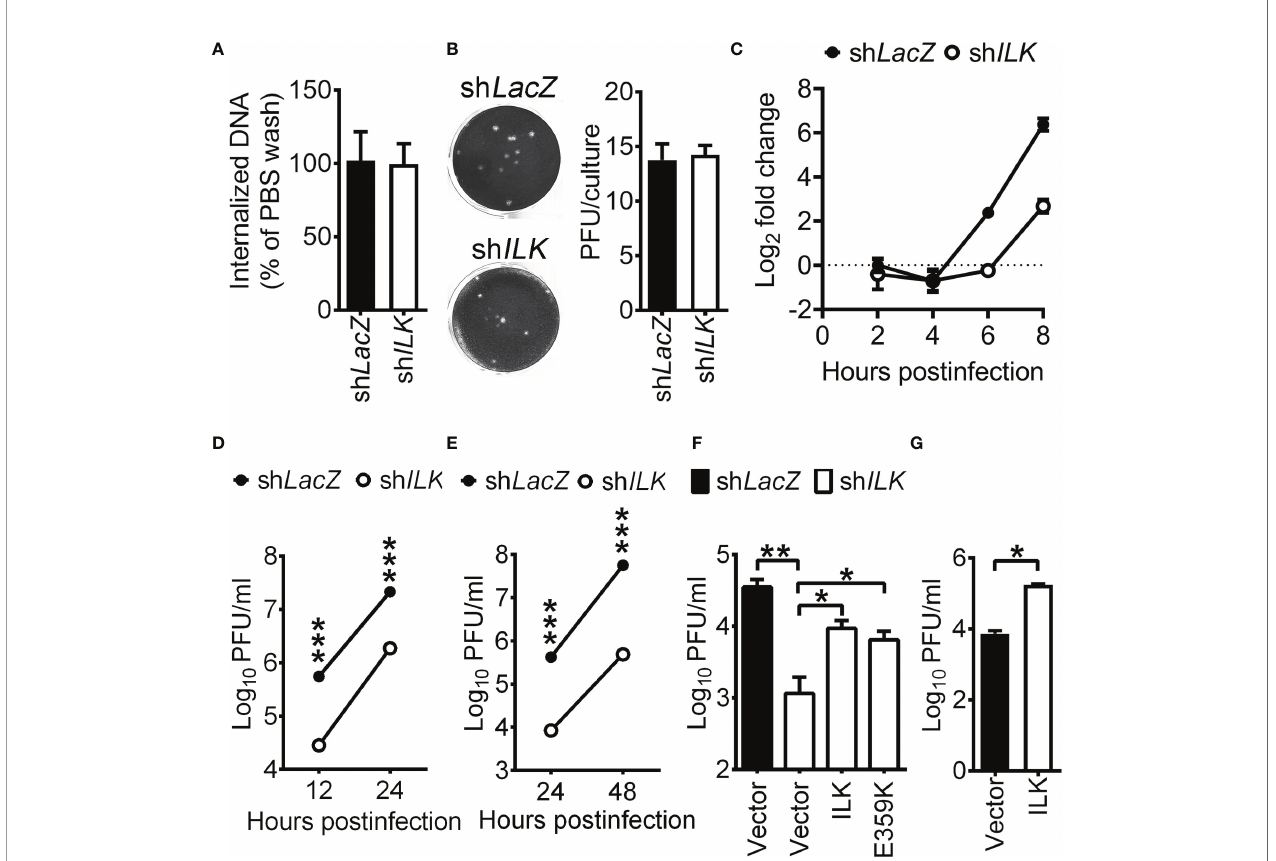
FIGURE 1 | ILK enhances HSV-1 replication independent of Akt activation. (A) The control (sh LacZ ) and ILK knockdown (sh ILK ) cells were infected with HSV-1, washed with citric buffer (pH = 3) or PBS, collected after trypsinization, and subjected to determine genome numbers via real-time PCR. The percentage of internalized viral DNA was calculated as the number of viral genomes in citric buffer-treated cells normalized to that of PBS-treated cells. (B) For the penetration assay, cells were infected with HSV-1 (20 PFU) at room temperature for 45 min, washed with citric buffer (pH = 3), and incubated in the medium with methylcellulose overlay for plaque formation. The representative images (left panel) and quantitative results (right panel) are shown. (C) The relative HSV-1 DNA levels in control and ILK knockdown cells infected with HSV-1 at indicated hours postinfection are shown. The level of HSV-1 DNA to internal control in control cells at 2 hours postinfection was set as 1. (D, E) The viral yields in the control and ILK knockdown cells infected with HSV-1 at MOI of 1 (D) or 0.01 (E) at indicated hours postinfection are shown. (F) The viral yields in the control and ILK knockdown cells transfected with a control vector (Vector) or the vector expressing wild-type ILK (ILK) or ILK E359K mutant and infected with HSV-1 (MOI = 0.01) at 24 hours postinfection are shown. (G) The viral yields in the SK-N-SH cells transfected with a control vector (Vector) or the vector expressing ILK (ILK) and infected with HSV-1 (MOI = 0.01) at 24 hours postinfection are shown. Data represent mean ± or + SEM (error bar). * p < 0.05, ** p < 0.01, *** p < 0.001 via Mann-Whitney U